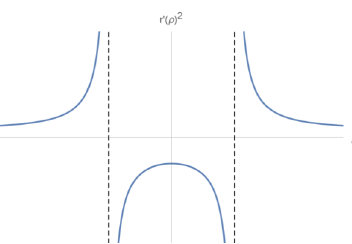
Figure 7. Singular speed-squared. The speed-squared ˙ r 2 is plotted here for the singular saddle shown in figure 6a. It has 1 type singularities where the contour hits the poles of the potential. ρ d ρ The action, which is the integral of ˙ r 2 , is finite because R ε may be defined by continuation ρ − ε around the pole. The imaginary part of the integral is ambiguous up to shifts by 2 πi Z , however, corresponding to the choice of how to deform the contour around the poles.